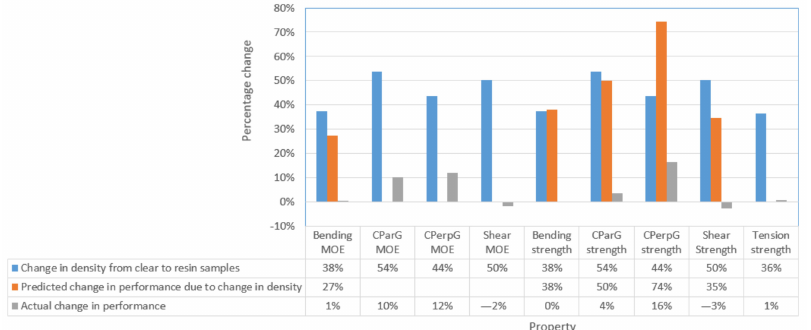
Figure 33. Change in density for resin samples, predicted and actual change in structural